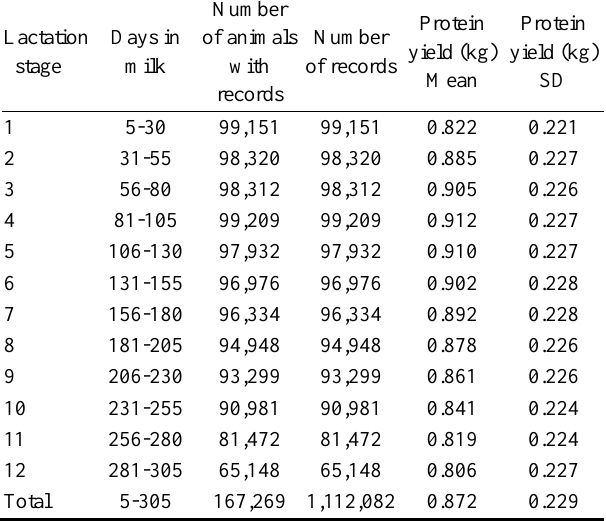
Table 1. Description of the data set used in the study Lactation